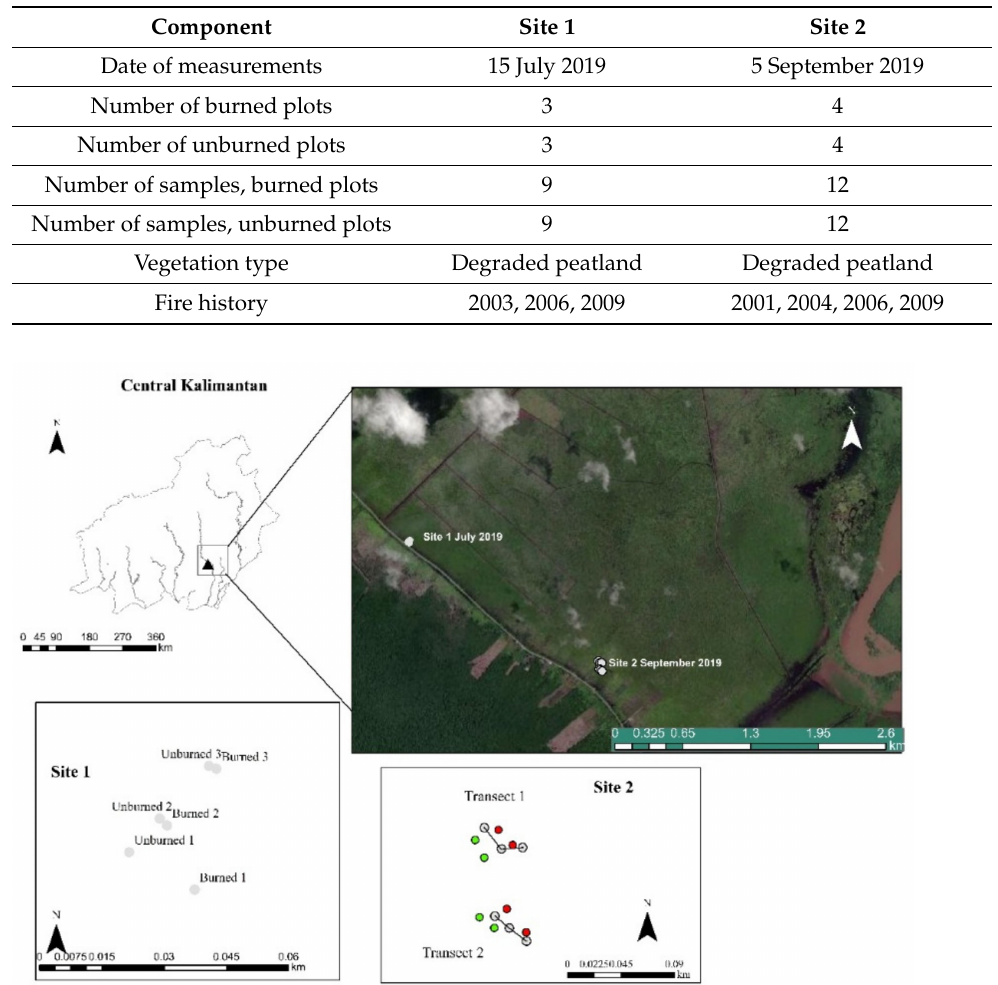
Figure 1. Map of the study area with sampling design. Site 1, showing the location of plots in burned and unburned areas. Site 2, showing the location of 2 transects for measuring the depth of peat burned and location of burned (red) and unburned (green)